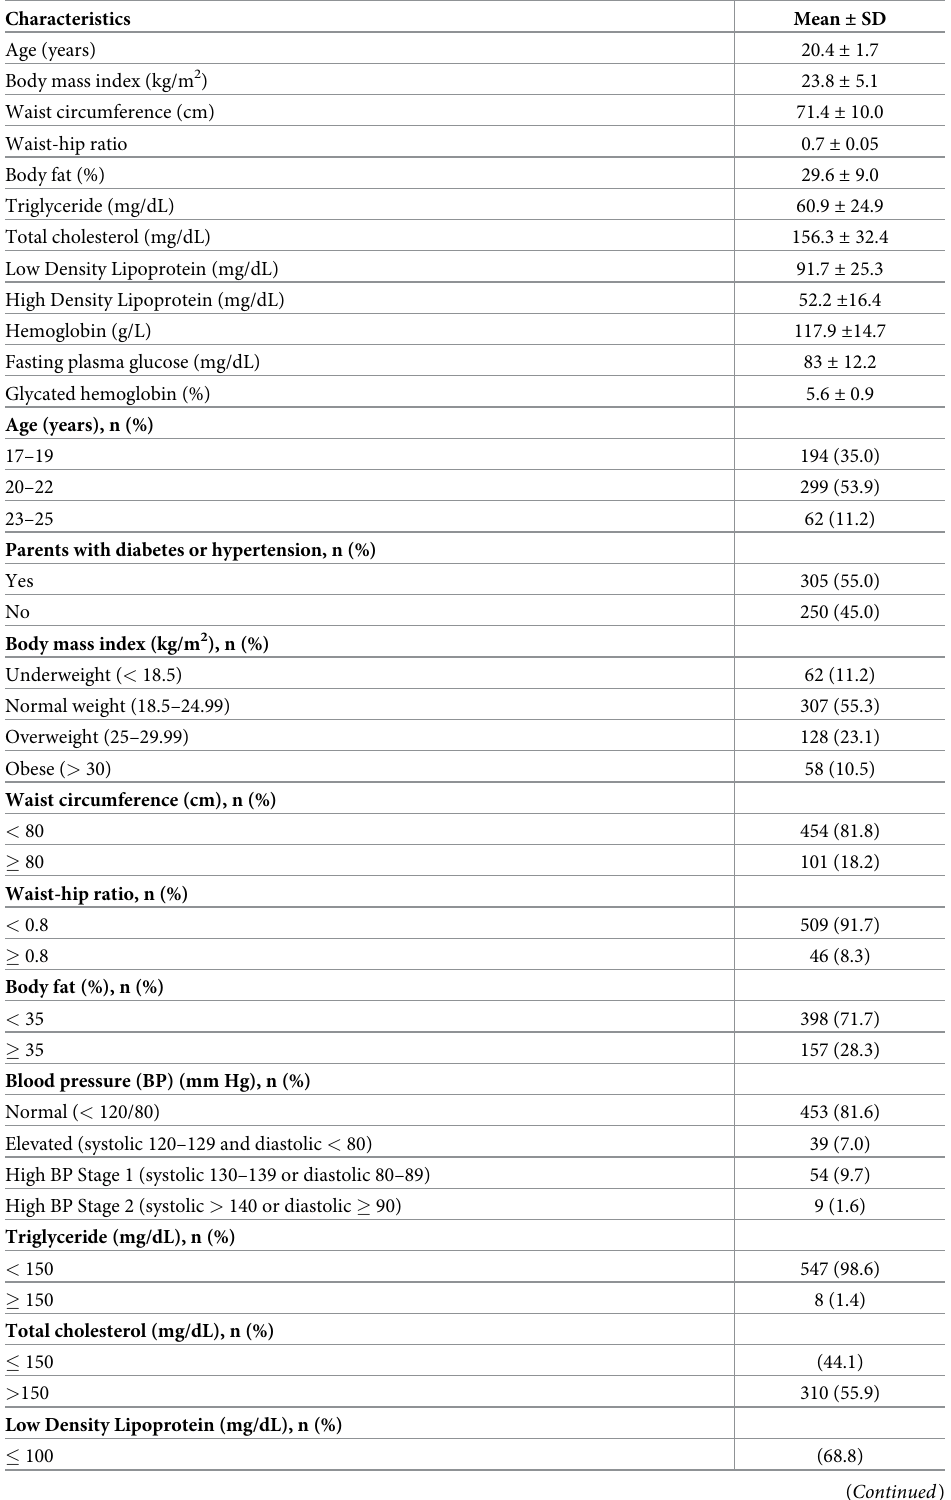
Table 1. Demographic and clinical characteristics of female participants (n = 555), at United Arab Emirates Uni- versity (UAEU), Al Ain,